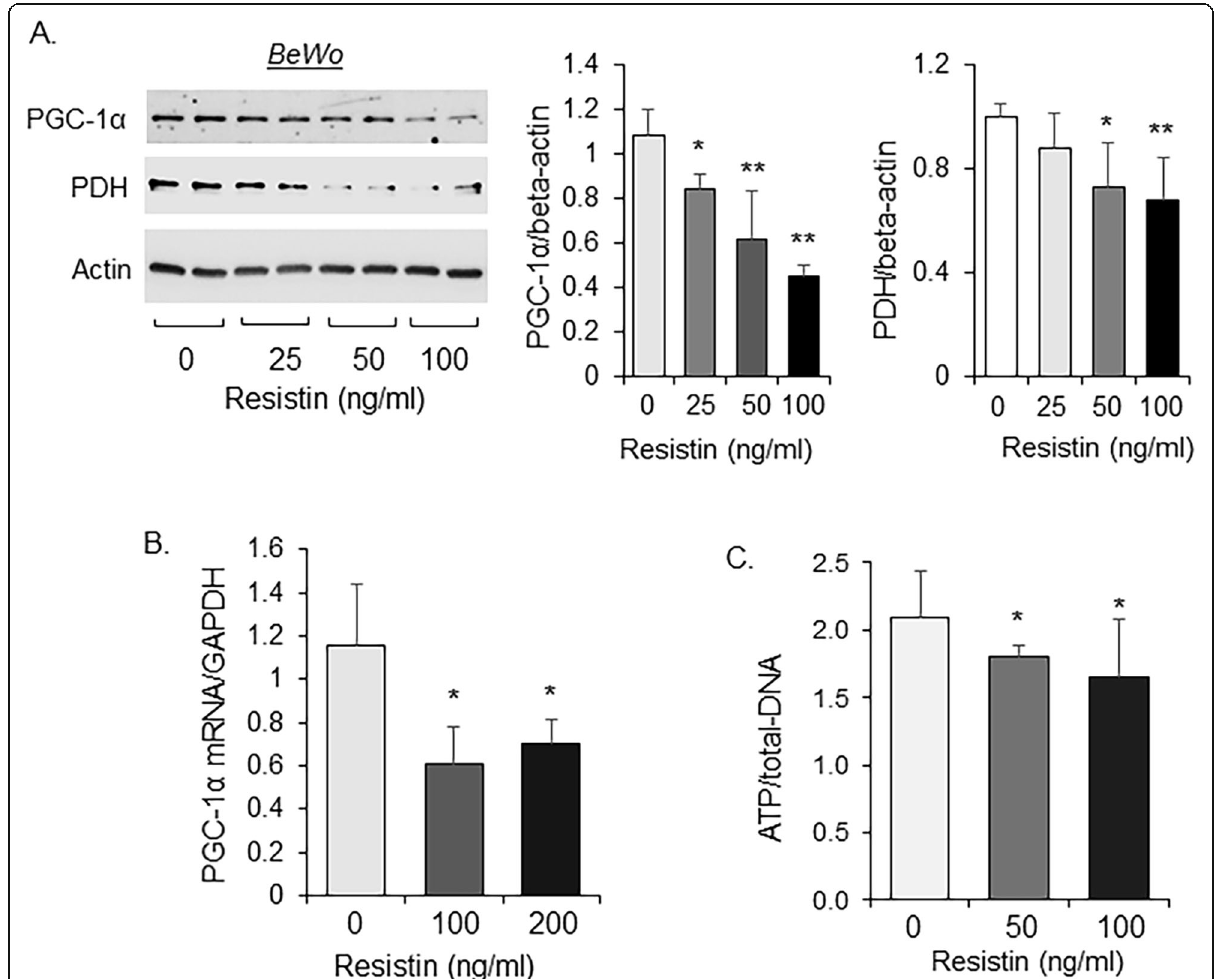
Fig. 5 Effect of resistin on PGC-1 α and mitochondrial metabolism in placental trophoblasts. BeWo cells were treated with indicated doses of human resistin for 24 h. a Protein lysates were subjected for Western blot analysis ( N = 4 in each group); b total RNAs were reverse-transcribed and subjected for RT-PCR ( N = 4 in each group); c BeWo cells were treated with indicated doses of human resistin in medium containing galactose for 24 h followed by assay for ATP levels ( N = 8 in each group). Mean ± SD * P < 0.05; ** P <